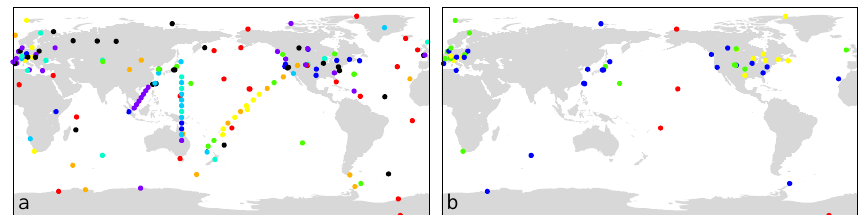
Fig. 1. Map of the site locations. Left shows all site locations used by any inversion with the color representing the number of inversions that use that site: black: 1, purple: 2, dark blue: 3, light blue: 4, cyan: 5–6, green: 7–8, yellow: 9, orange: 10, red: 11; right: in situ sites that are used by up to 4 inversions at hourly or daily temporal resolution. Color indicates the number of inversions, 1 (blue), 2 (green), 3 (yellow), 4